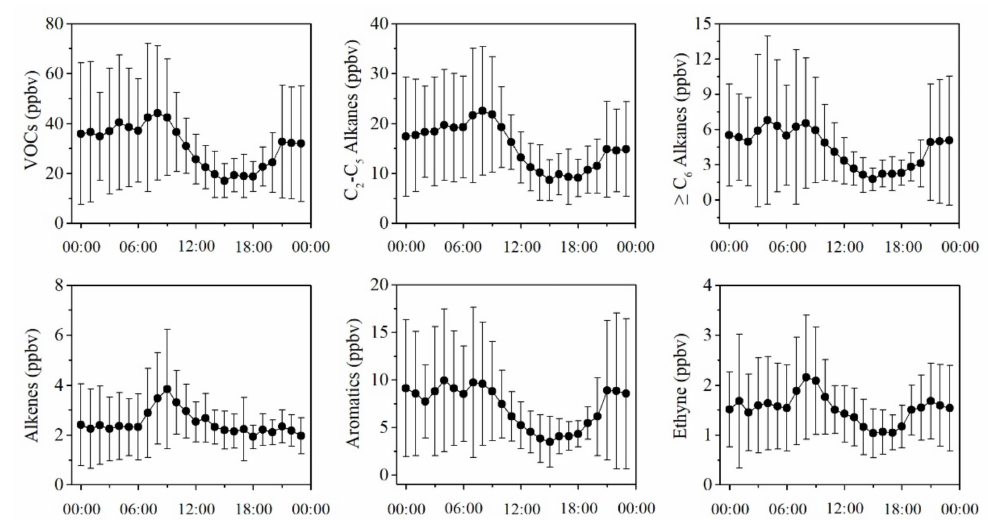
Figure 4. Diurnal variations of VOCs and the main